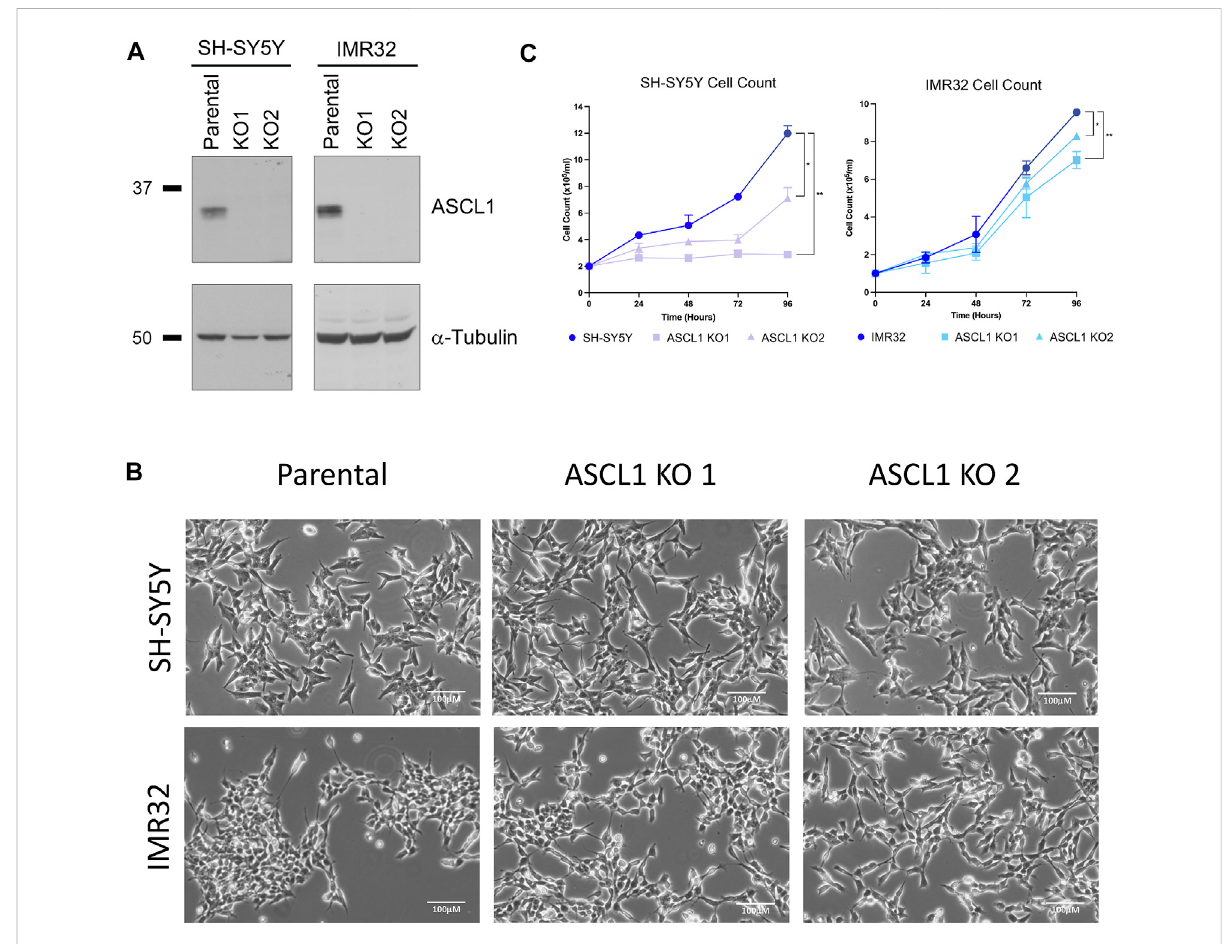
FIGURE 1 ASCL1 was successfully knocked out of two neuroblastoma lines. (A) CRISPR-Cas9 was used to delete ASCL1 from SH-SY5Y and IMR32 cell lines. Western blotting to show the ASCL1 expression levels in parental lines and in lines following ASCL1 KO, α -tubulin was used as the loading control (SH-SY5Y left and IMR32 right). (B) Phase contrast microscopy images to show the morphology of cells following ASCL1 KO. (C) Cell count data of parental and ASCL1 KO cells over a96-h period. n = 3, graphs show mean value and ± SEM (unpaired two-tailed t -test * = p < 0.05, ** = p < 0.005; SH-SY5Y left and IMR32